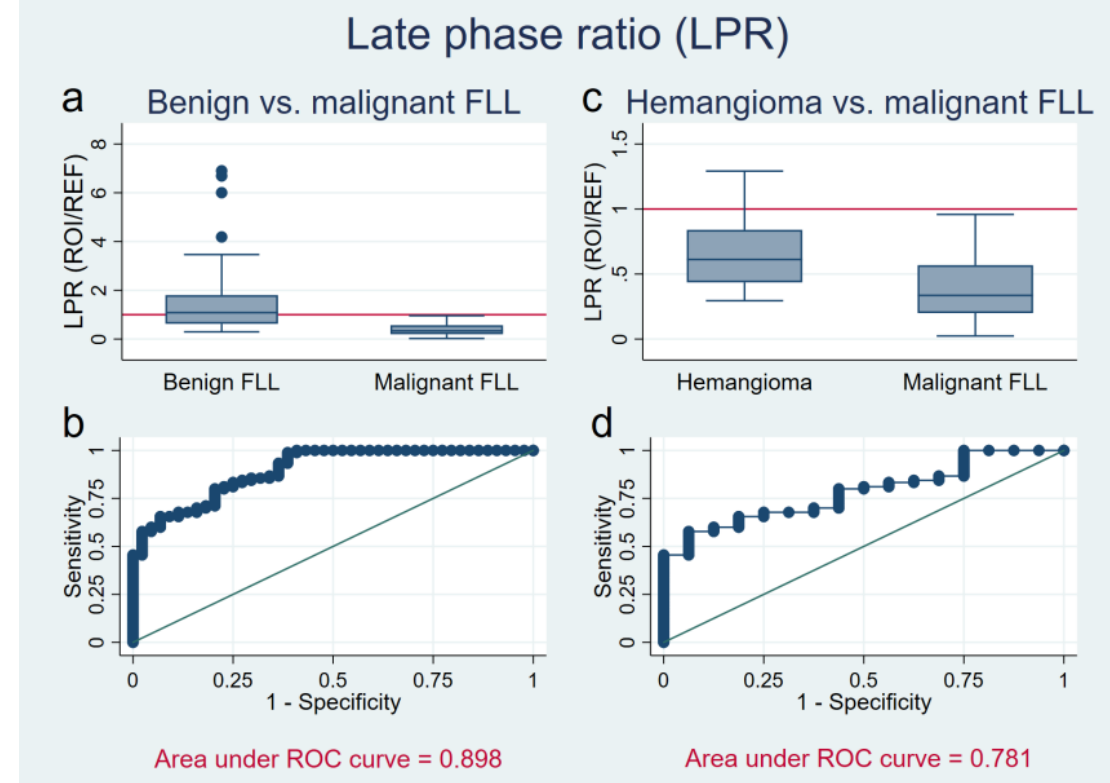
Figure 4. Late phase ratio (LPR) of benign liver lesions ( a , b ), and in a subgroup analysis of hemangiomas ( c , d ) versus malignant focal liver lesions (FLL). ( a , c ) The Y axis shows the LPR (region of interest/reference) of benign ( a ) FLL and hemangiomas ( c ) in comparison to malignant FLL. Red reference line at 1, values below indicating hypoechogenicity, values above hyperechogenicity. For malignant tumors, the ratio lies below 1 and therefore differ significantly ( p < 0.001) from benign FLL ( a ). Hemangiomas present variable, in many cases mildly hypoechoic. Still, they differ significantly from malignancies ( p < 0.001) ( c ). ( b , d ) ROC curve of LPR ( X axis: 1-Specifity; Y axis: Sensitivity) in discriminating malignant from benign liver lesions (Area under ROC curve = 0.898) ( b ), and malignant lesions from hemangiomas (Area under ROC curve = 0.781) ( d ).